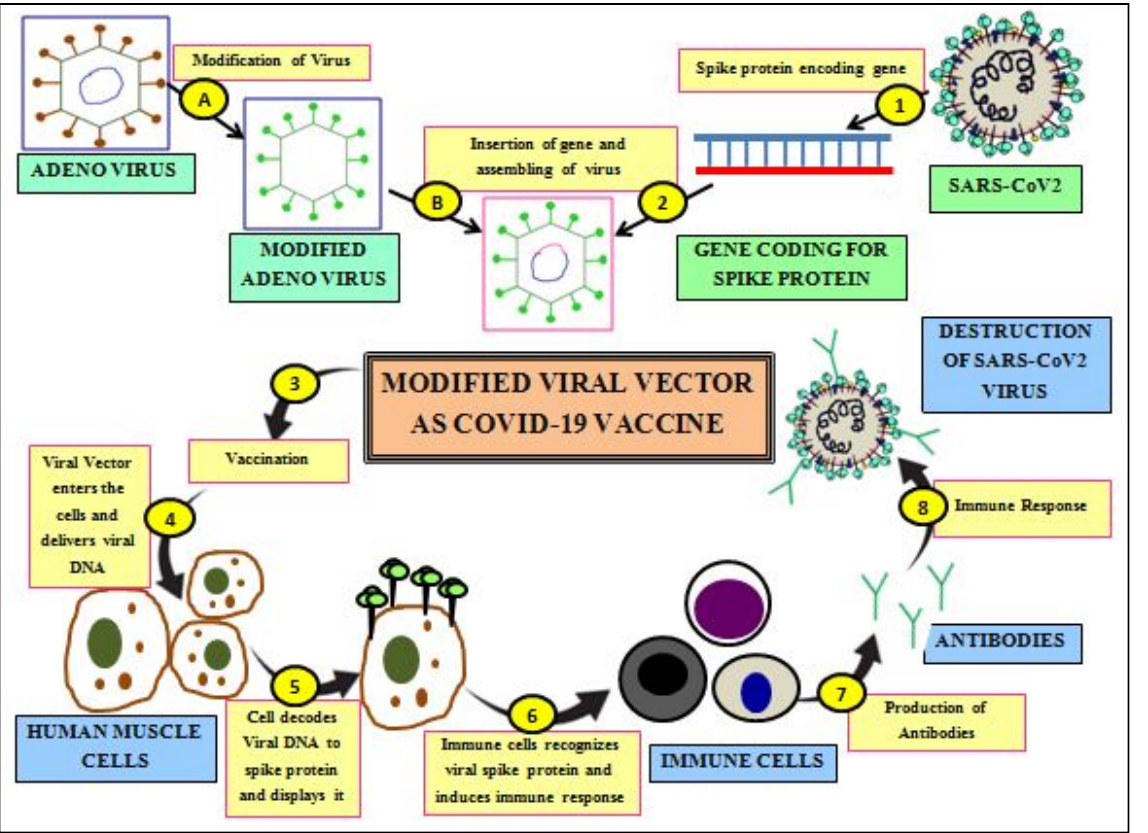
Figure 10. Viral vector-based vaccines for the treatment of COVID-19: ( 1 ) modification of adenovirus by removing pathogenic genes to make them non-infectious; ( 2 ) insertion of a gene of interest encoding the SARS-CoV-2 virus’s spike protein into an adenovirus system; ( 3 ) making a modified adenovirus-based vaccine and their administration into individuals; ( 4 ) adhesion of a viral vector to human cells and delivery of the antigenic determinant; ( 5 ) expression of a viral vector antigenic determinant (spike protein) and its display on the surface of human cells; ( 6 ) recognition of viral spike protein by immune cells; ( 7 ) immune cells’ production of antibodies (NABs) against viral spike protein; ( 8 ) immune responses with elicited antibodies neutralize the SARS-CoV-2 virus in vaccinated people.